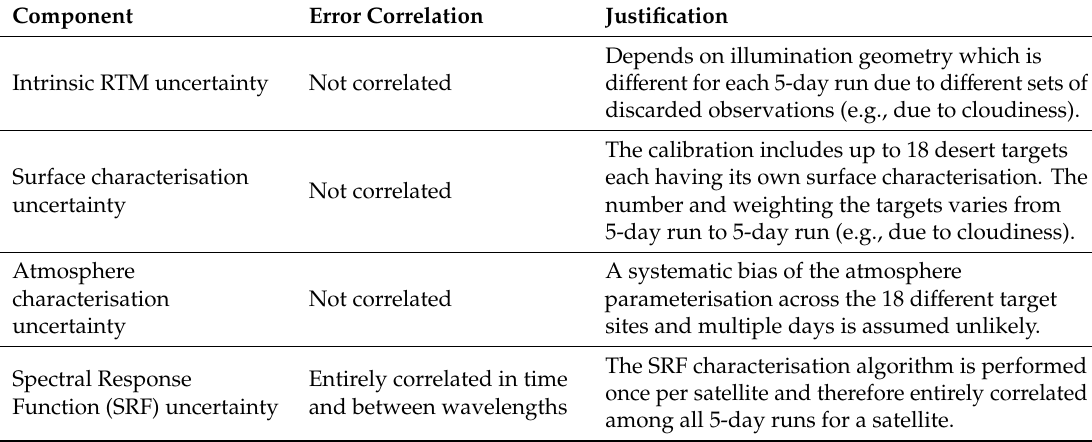
Table 3. Uncertainty components of the count-radiance ratios that result from a 5-day calibration run and the correlations between the errors of count-radiance ratios from multiple 5-day calibration runs. Component Error Correlation Justification Depends on illumination geometry which is Intrinsic RTM uncertainty Not correlated di ff erent for each 5-day run due to di ff erent sets of discarded observations (e.g., due to cloudiness). The calibration includes up to 18 desert targets each having its own surface characterisation. The Not correlated number and weighting the targets varies from 5-day run to 5-day run (e.g., due to cloudiness). parameterisation across the 18 di ff erent